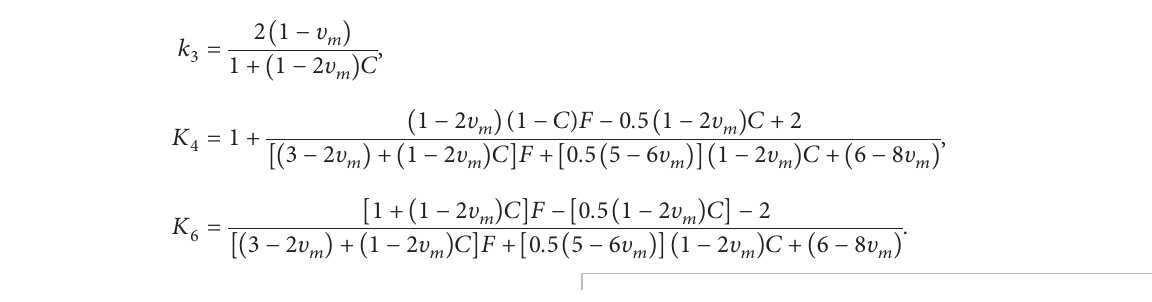
Figure 1: Tunnel lining geometry and finite element model of rock mass and tunnel in ABAQUS software